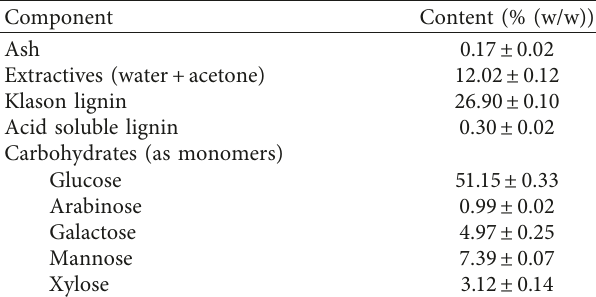
Table 1: Chemical composition of larch sawdust, reported as mean ( n (cid:31)